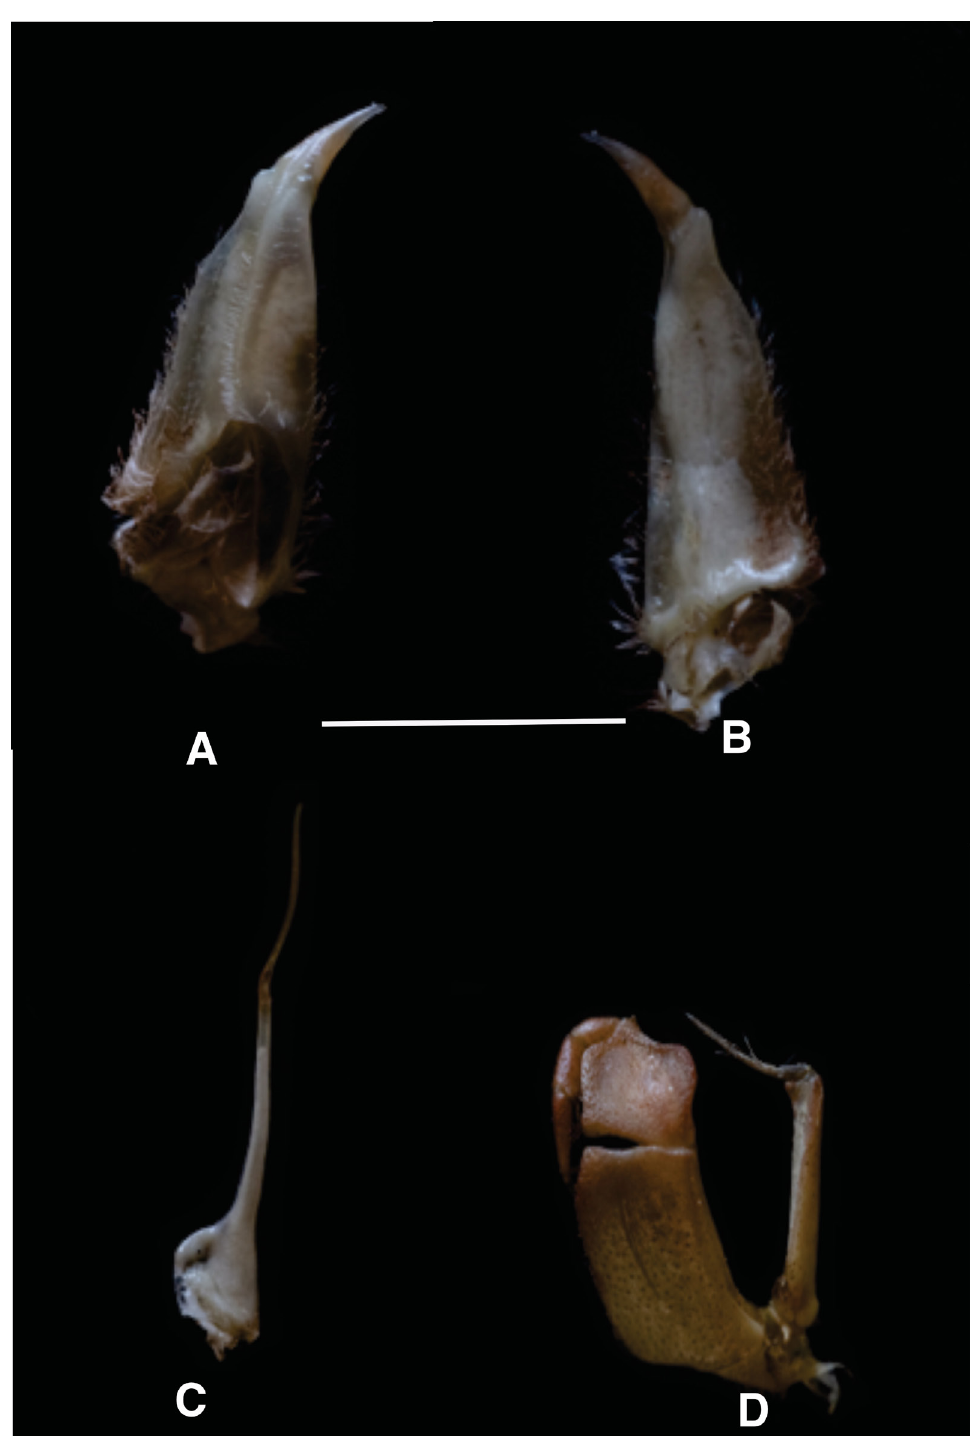
Fig. 9. Potamonautes baziya sp. nov., ♂, holotype (SAM A-094474) A . Left gonopod 1, anterior view. B . Left gonopod 1, posterior view. C . Left gonopod 2, anterior view. D . Right third maxilliped. Scale bar = 10